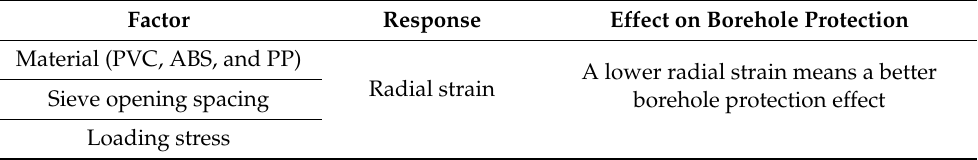
Table 1. Factors and response of experimental